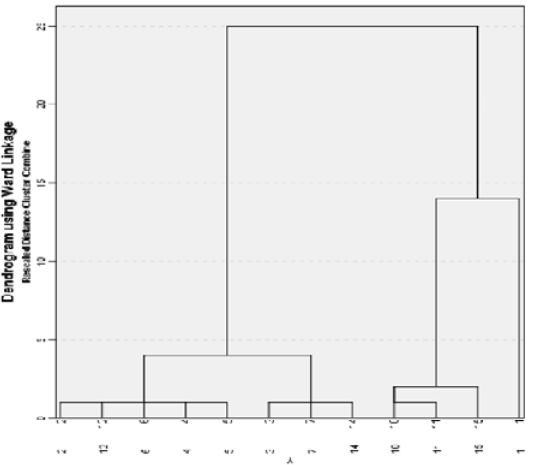
Fig. 4b: Durov diagram for UAE brands